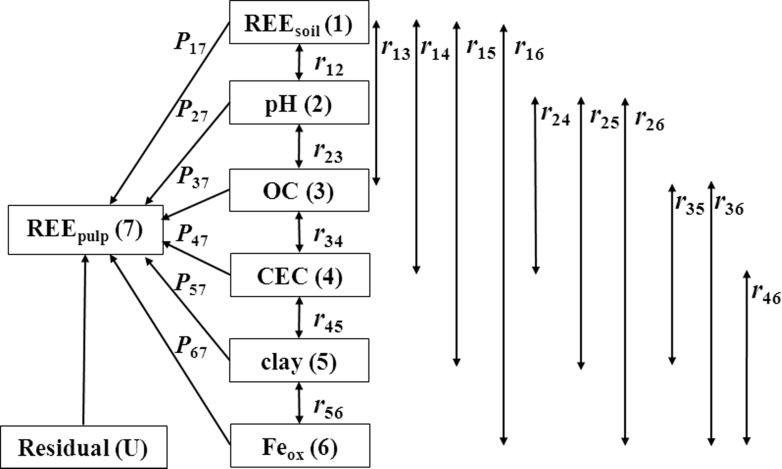
The path analysis diagram for the relationship between REE content in navel orange pulp and soil REE or soil properties.Single-headed arrows represent the direct effects (P
ij), and double-headed arrows indicate the coefficients of the correlations between soil REE and the soil properties (r
ij). Subscript designations for soil REE, the soil properties, and the REE content in the navel orange pulp are identified numerically as follows: (1) REE content in soil; (2) soil pH; (3) organic carbon (OC); (4) cation exchange capacity (CEC); (5) clay; (6) Fe oxide (Feox); (7) REE content in the pulp.